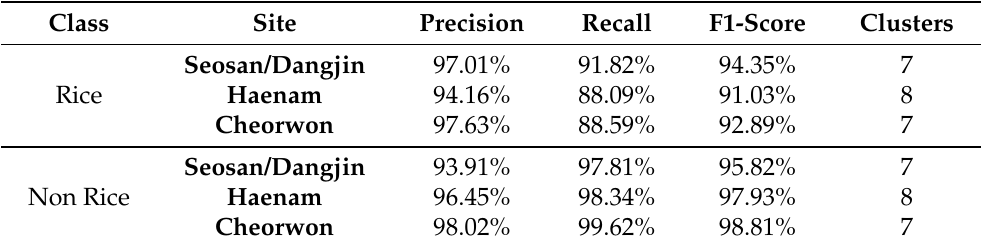
Table 2. Pseudo-labeling performance metrics and the optimal number of clusters for the rice and non-rice class per